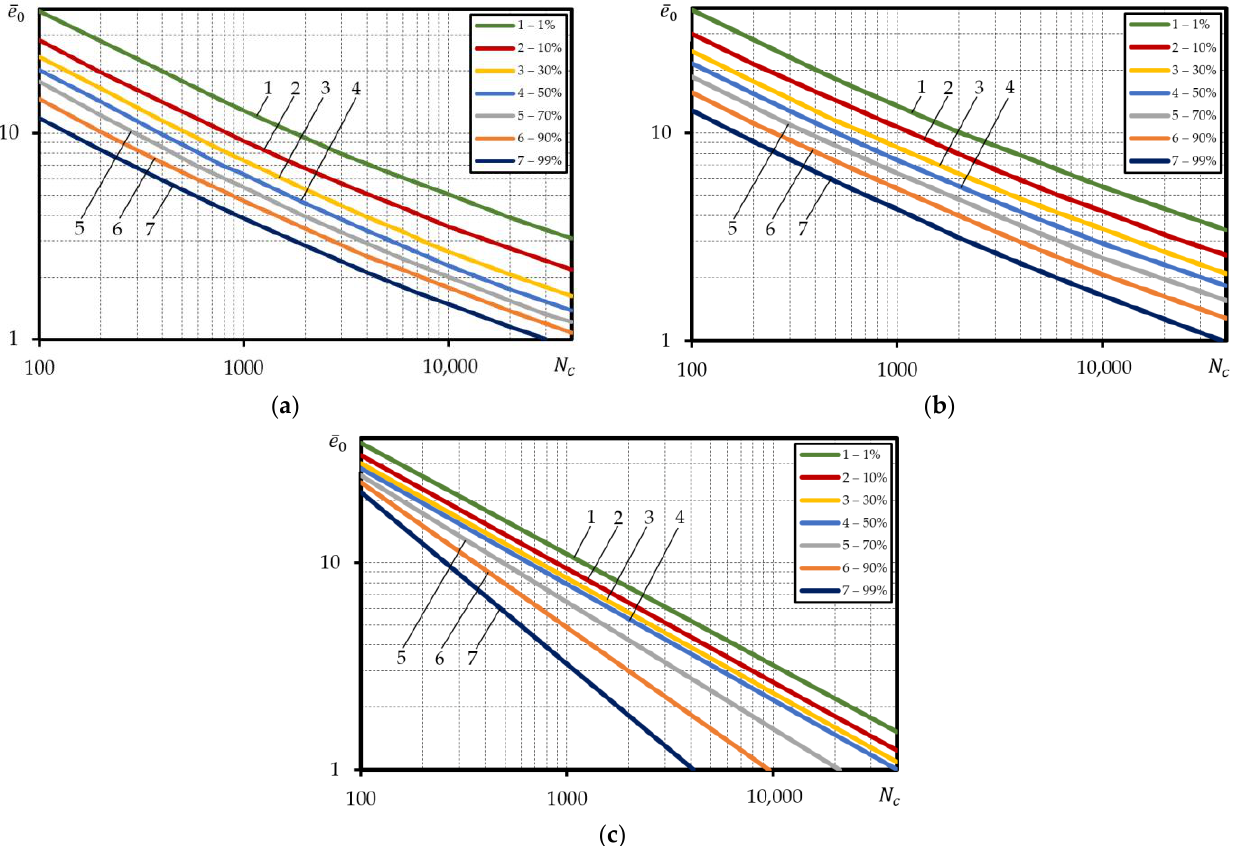
Figure 7. Calculated probabilistic low-cycle fatigue curves under strain-controlled loading for steel 15Cr2MoVA, built in the relative coordinates, according to: ( a ) — Equation (3), ( b ) — Equation (5), ( c ) — Equation (6).